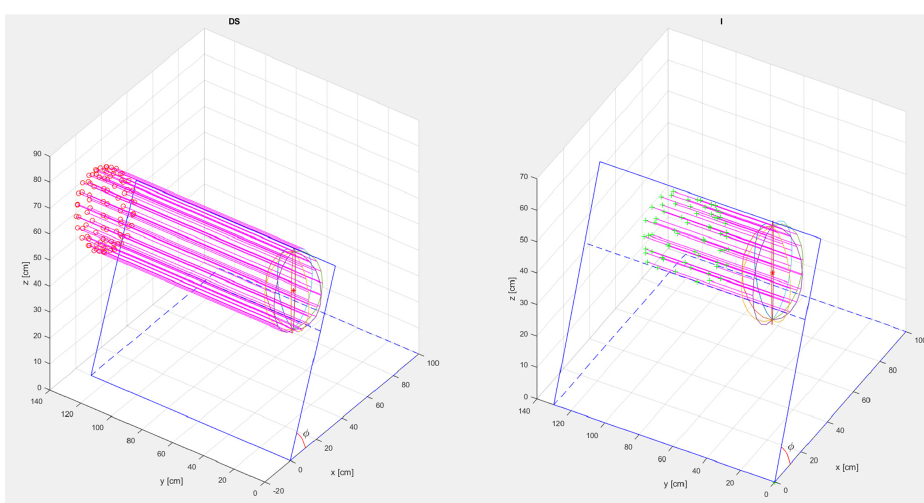
Figure 15. Test scenario 3—S is a fixed point and D is a mobile point.